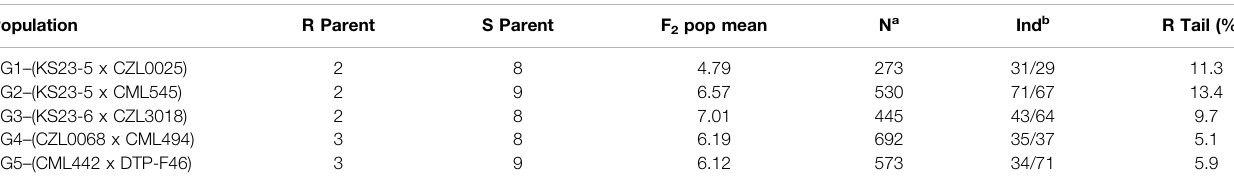
TABLE 1 | MLN disease severity and descriptive statistics of the SG populations under arti fi cial inoculation at the MLN Screening Facility, Naivasha, Kenya. Population R Parent S Parent F 2 pop mean N a Ind b R Tail (%) c